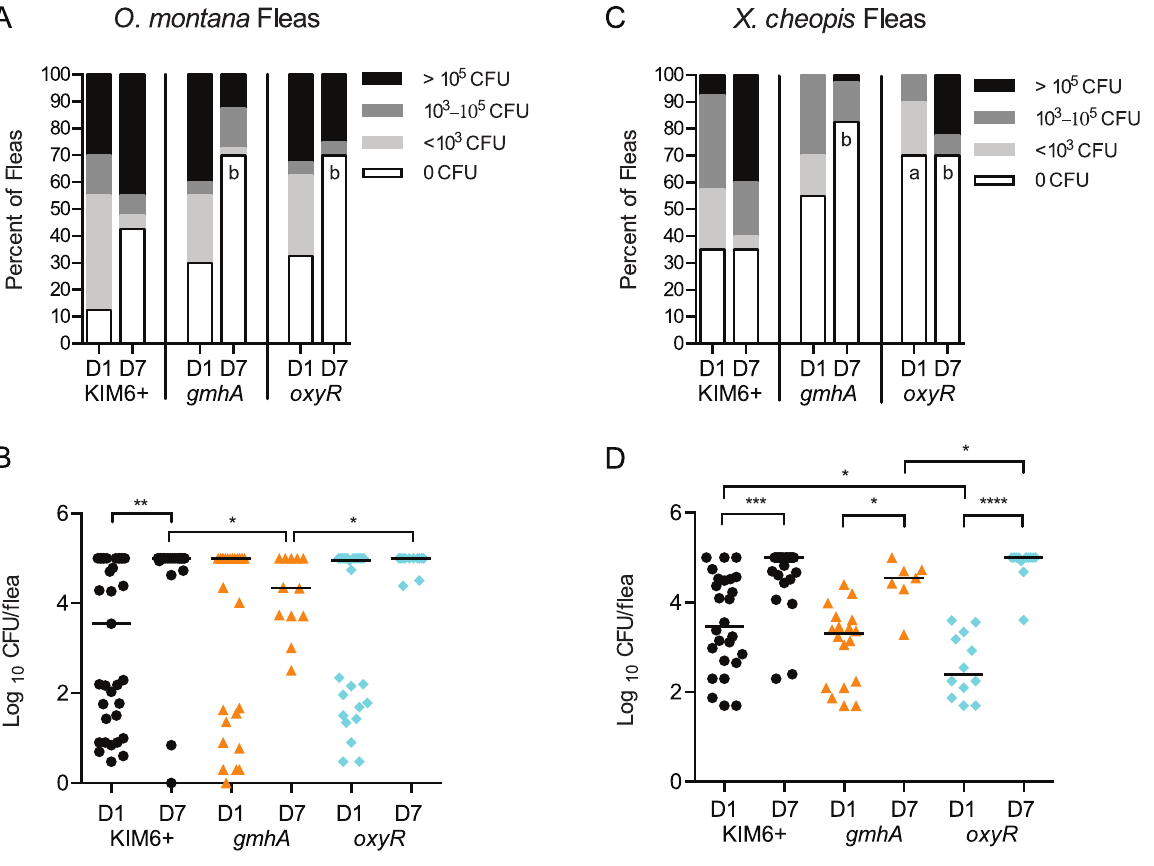
Fig 7. Colonization of Y . pestis mutants in O . montana and X . cheopis fleas. O . montana (panels A-B) or X . cheopis (panels C-D) fleas fed on blood containing 1x10 9 CFU of the indicated Y . pestis strains. On days 0, 1 (D1) and 7 (D7) post-infection, fleas were mechanically disrupted and enumerated on heart infusion agar. Day 0 data are shown in S2 Fig. Panels A and C: Fleas were grouped according to their bacterial burden and are represented as a percentage of the total population for that bacterial strain and day. Minimum limit of detection was 1 CFU; Maximum limit of detection was 10 5 CFU. Data shown were collected in 1 (A-B) or 2 (C-D) independent trials; n = 40 fleas per strain per day. Data were analyzed by Chi-square test with Bonferonni post- test, comparing each mutant to KIM6+, with a significance level of P < 0.025. "a" denotes significant comparisons on day 1; "b" denotes significant comparisons on day 7. Panels B and D: Analysis of only infected fleas from Panels A and D; fleas with 0 CFU not included. Bacterial load from each infected flea is displayed, and the bar in each lane indicates the population median. A Kruskal-Wallis non-parametric analysis with Dunn's post-test for multiple comparisons was performed, and significant pairwise comparisons are indicated: * P < 0.05, ** P < 0.01, *** P < 0.001, **** P < 0.0001.